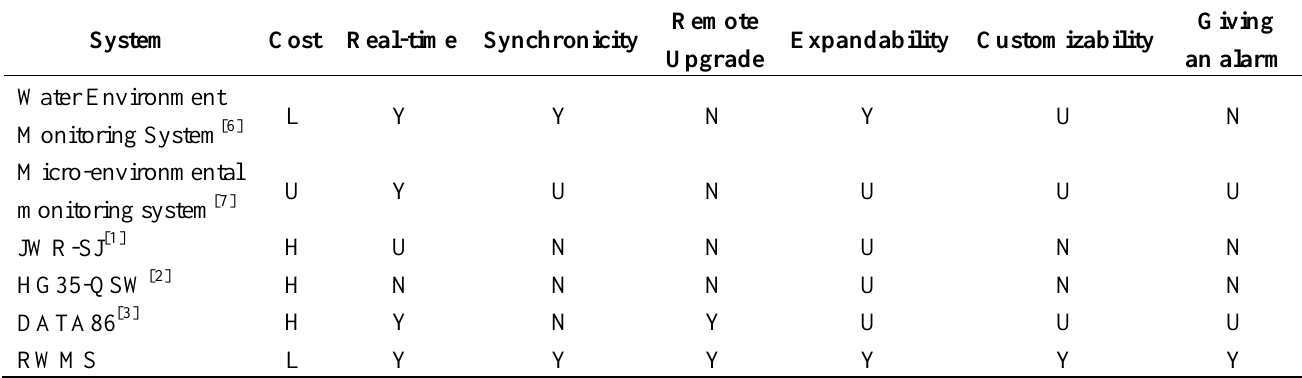
Table 1 . Comparation of different systems.